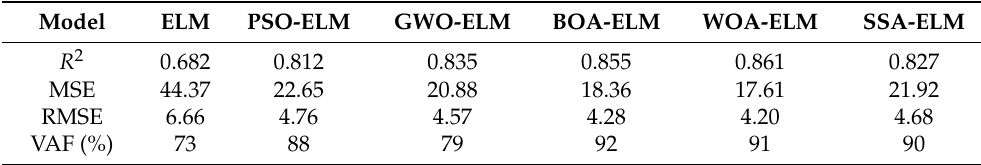
Table 3. Performance indices of the proposed predictive models. Model